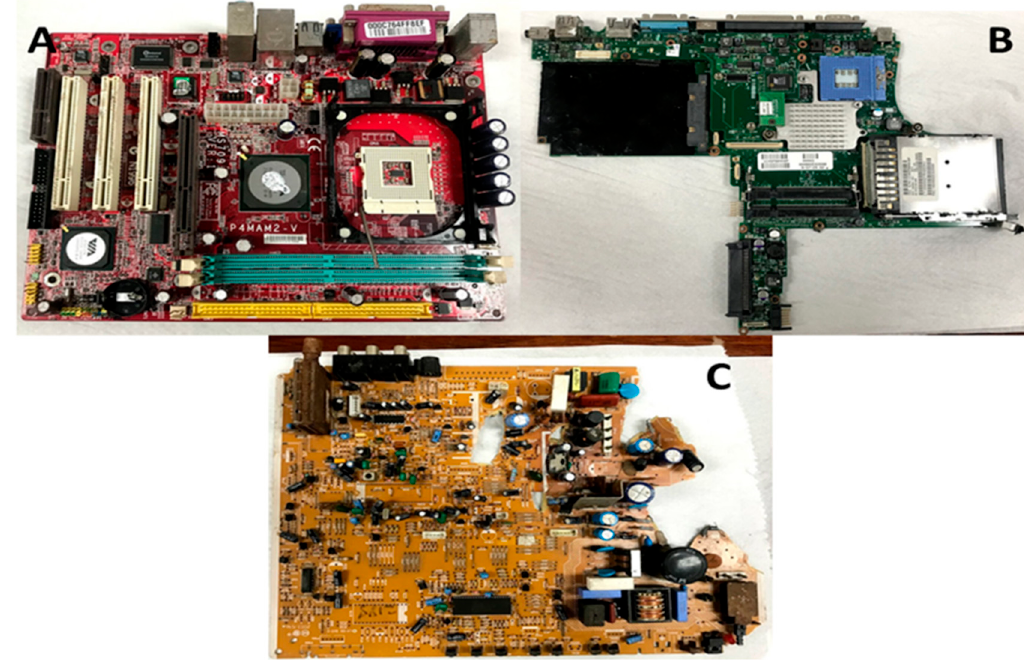
Figure 5. Different types of printed circuit boards: ( A ) desktop computer, ( B ) laptop, and ( C ) television.